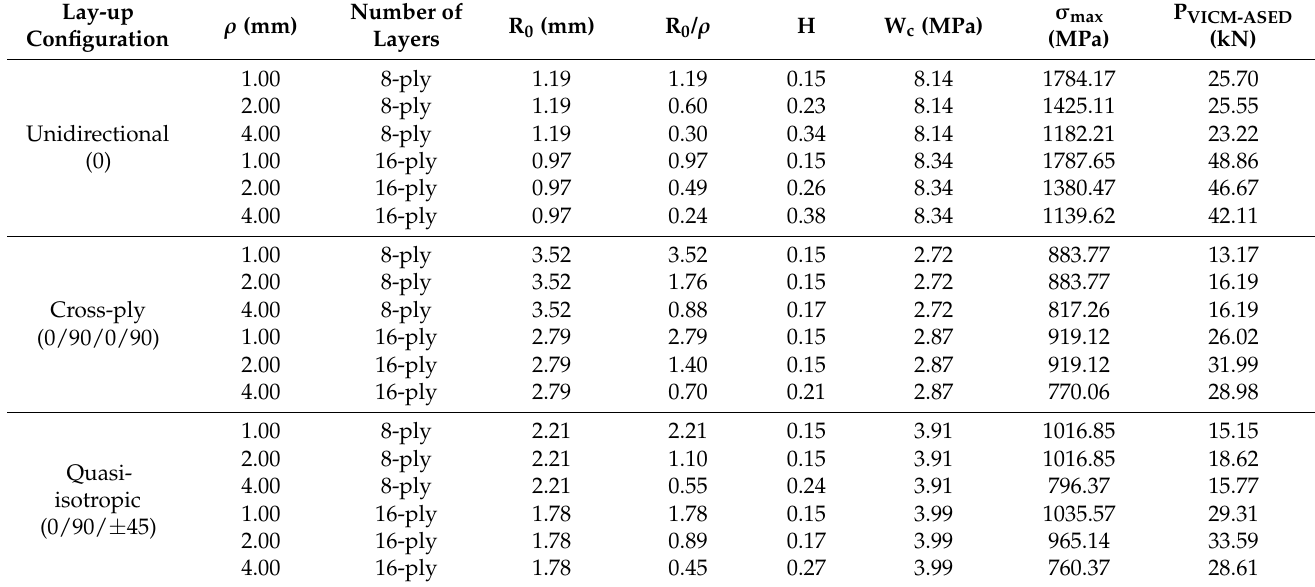
Table 4. Average strain energy density (ASED) parameters together with the Virtual Isotropic Material Concept (VIMC)– ASED critical loads. Lay-up Configuration